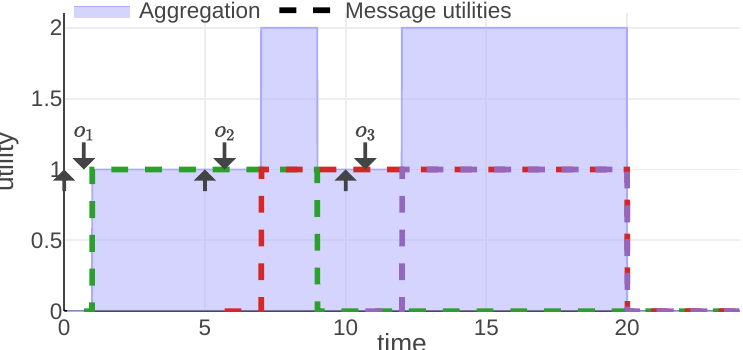
Figure 6. A objective and U objective functions plotted for a mission example. c (cid:13) 2019 IEEE. Reprinted, with permission, from